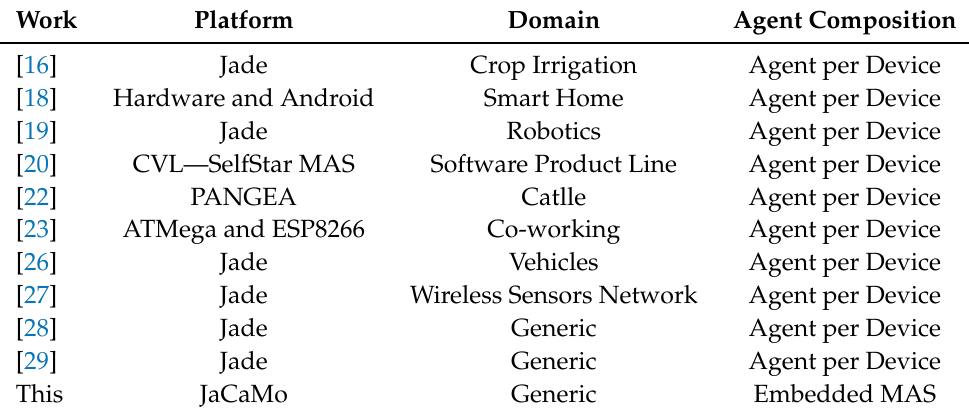
Table 1. Comparison between the related